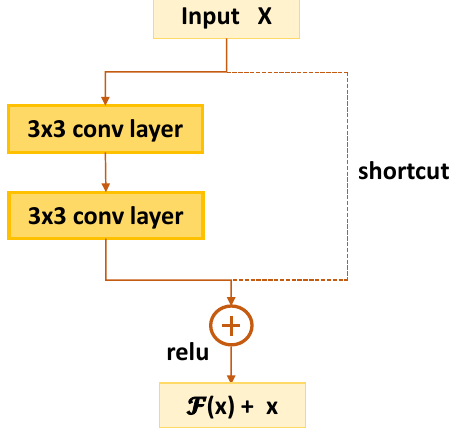
Figure 3. Structure of an internal residual block